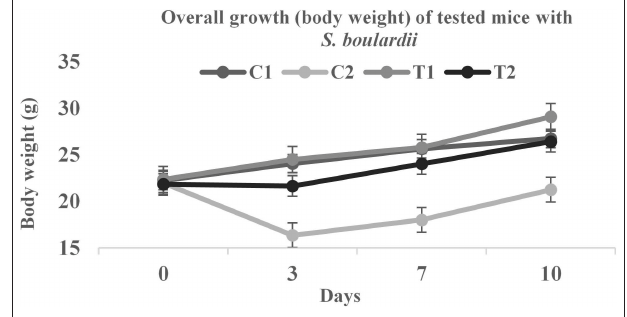
FIGURE 4 | Body weight comparison of tested